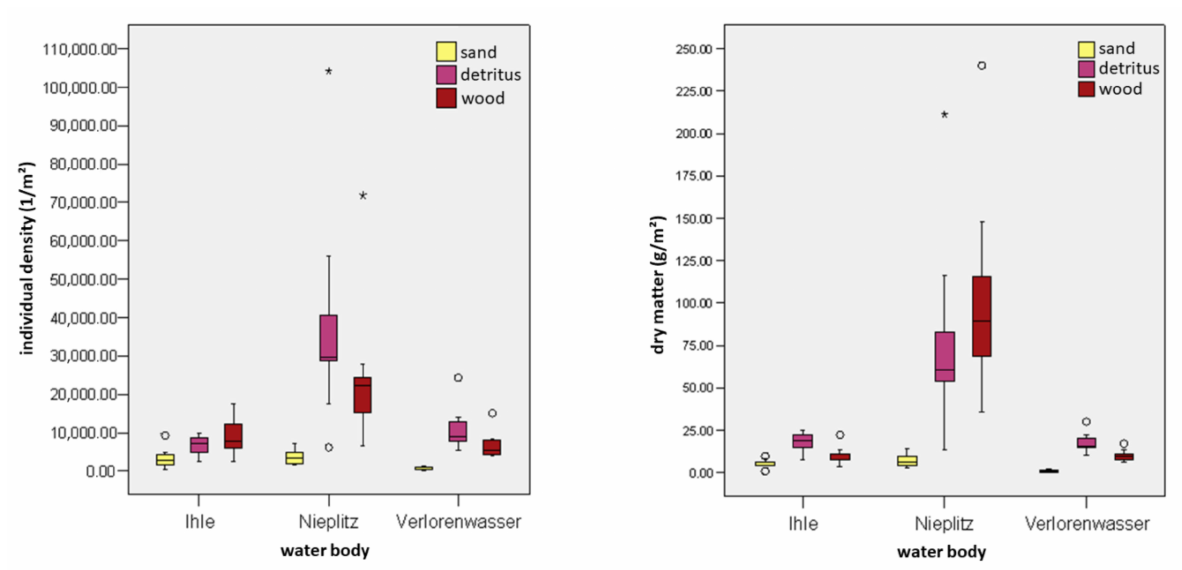
Figure 6. Density of individuals per m 2 ( left ) and dry matter in g per m 2 ( right ) of MI for the substrates sand, detritus and wood of WS, divided among the water bodies Ihle, Nieplitz, and Verlorenwasser. The box plots show the minimum (lower antenna), the two quartiles, the median, and the maximum (upper antenna) of the distributions. The circles marks are suspected to be outliers, and the star marks the extreme values of the distributions.